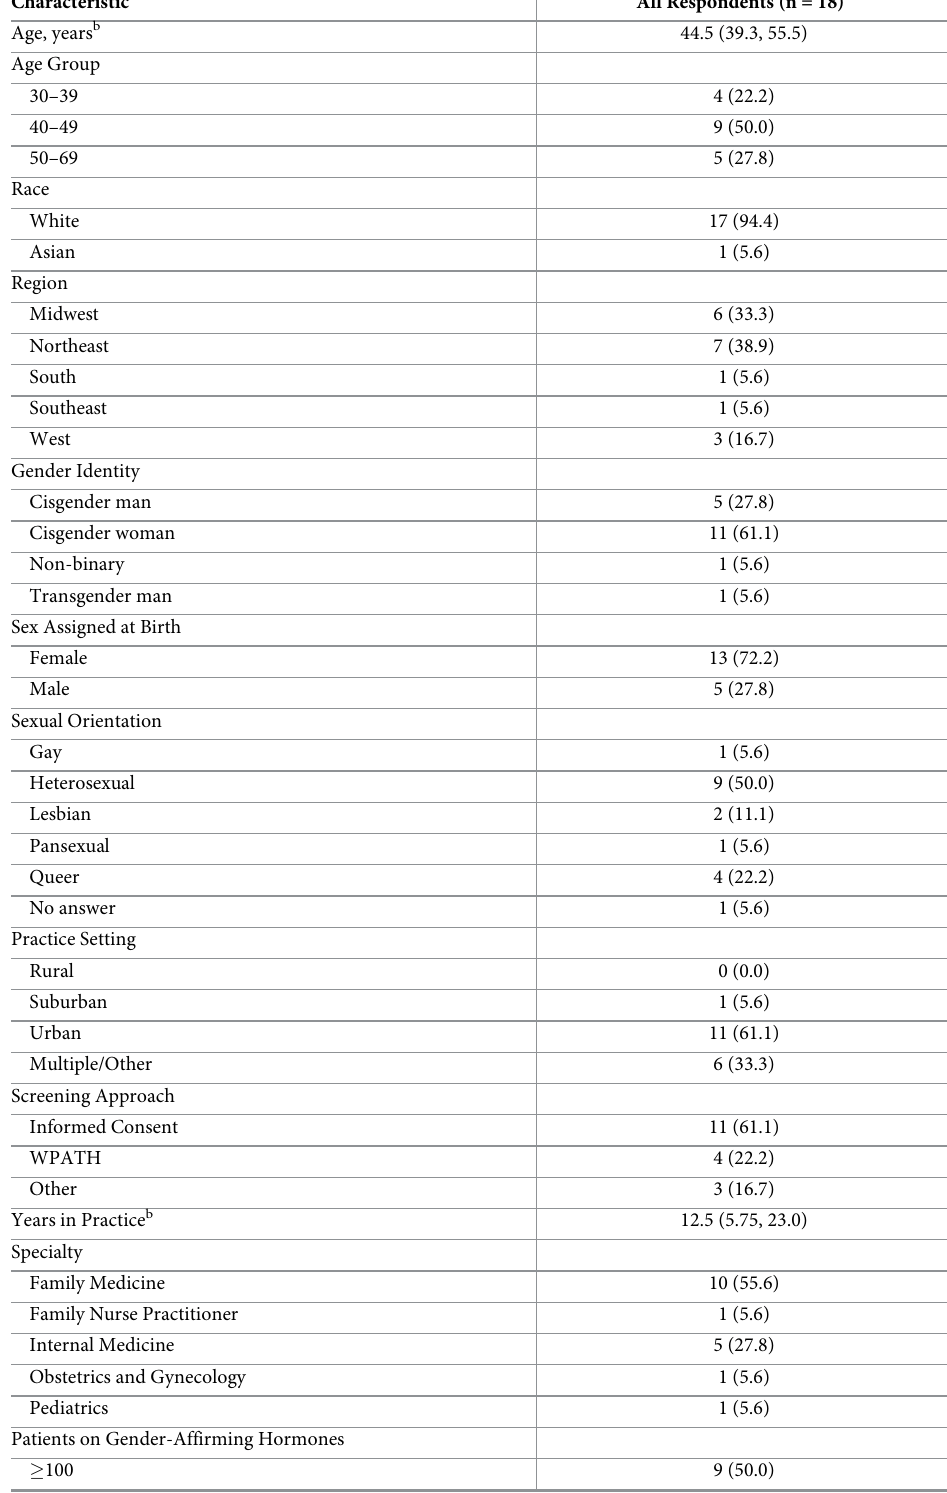
Table 1. Characteristics of